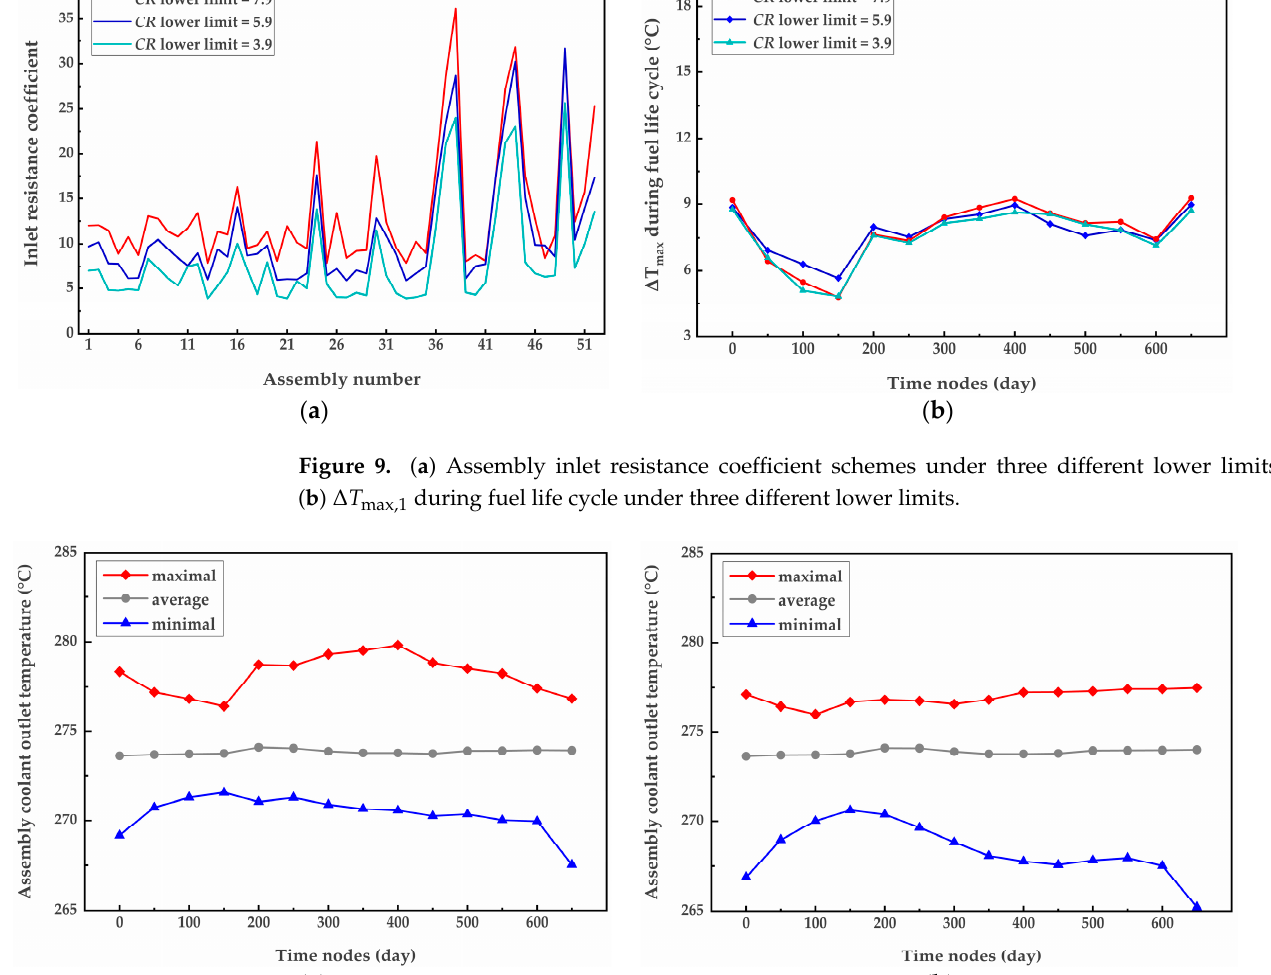
T Δ is defined as m ax